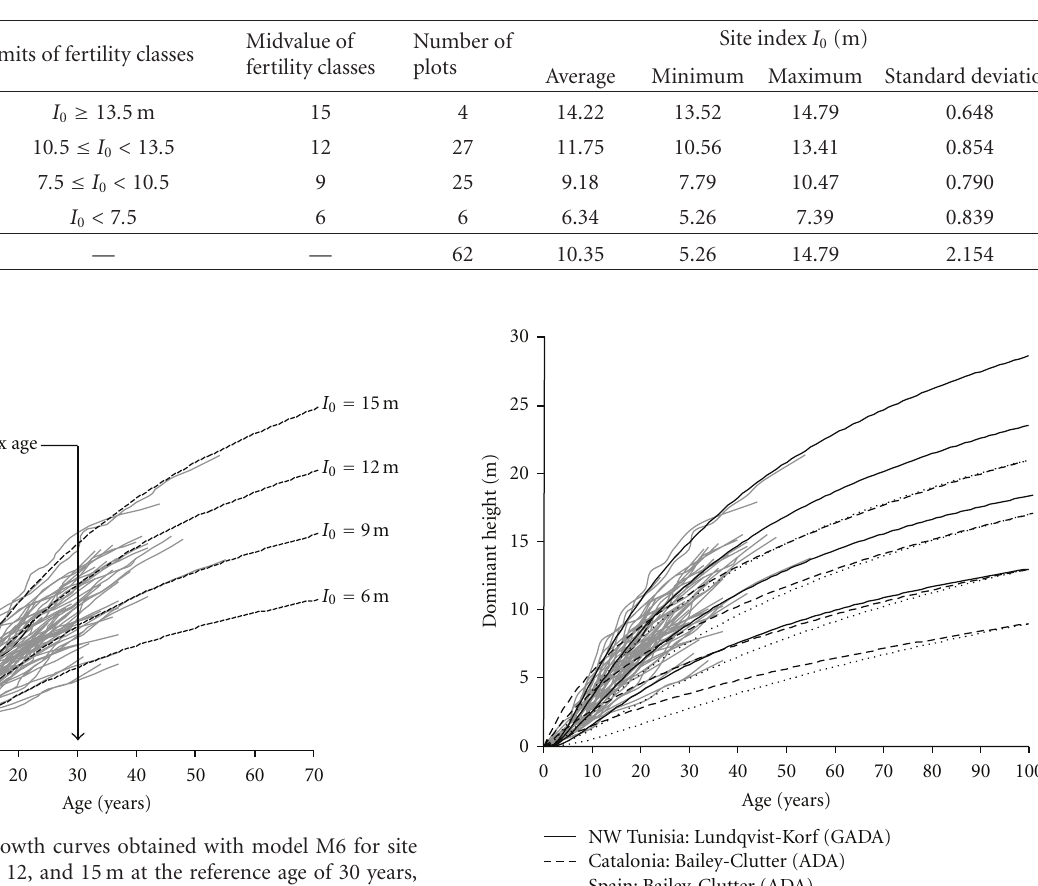
Table 4: Distribution of sampled plots in fertility classes and descriptive statistics of site index I 0 values estimated for the plots of each fertility class.